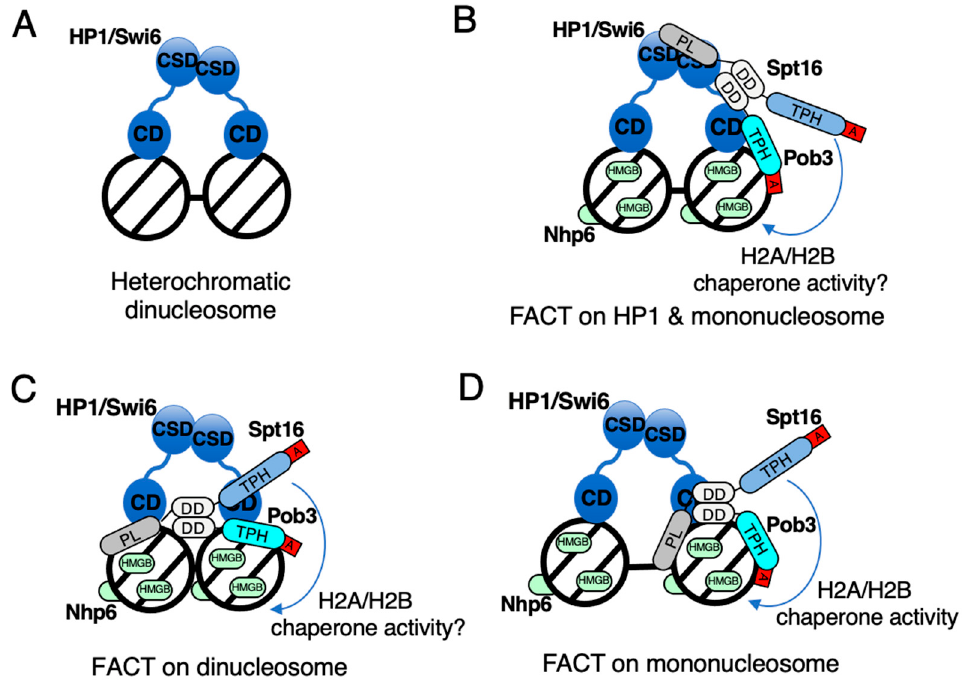
Figure 6. Hypothetical FACT working model on heterochromatic nucleosomes. PL: peptidase-like domain, TPH: tandem PH domain, DD: dimerization domain, A: acidic cluster, CD: chromodomain, CSD: chromo-shadow domain. ( A ) HP1/Swi6 bridge dinucleosome. ( B ) FACT is recruited by a Swi6-CSD homodimer via the peptidase-like domain of Spt16. ( C ) HP1/Swi6 and FACT cooperatively bridge dinucleosome. ( D ) FACT binds to heterochromatic mononucleosome.